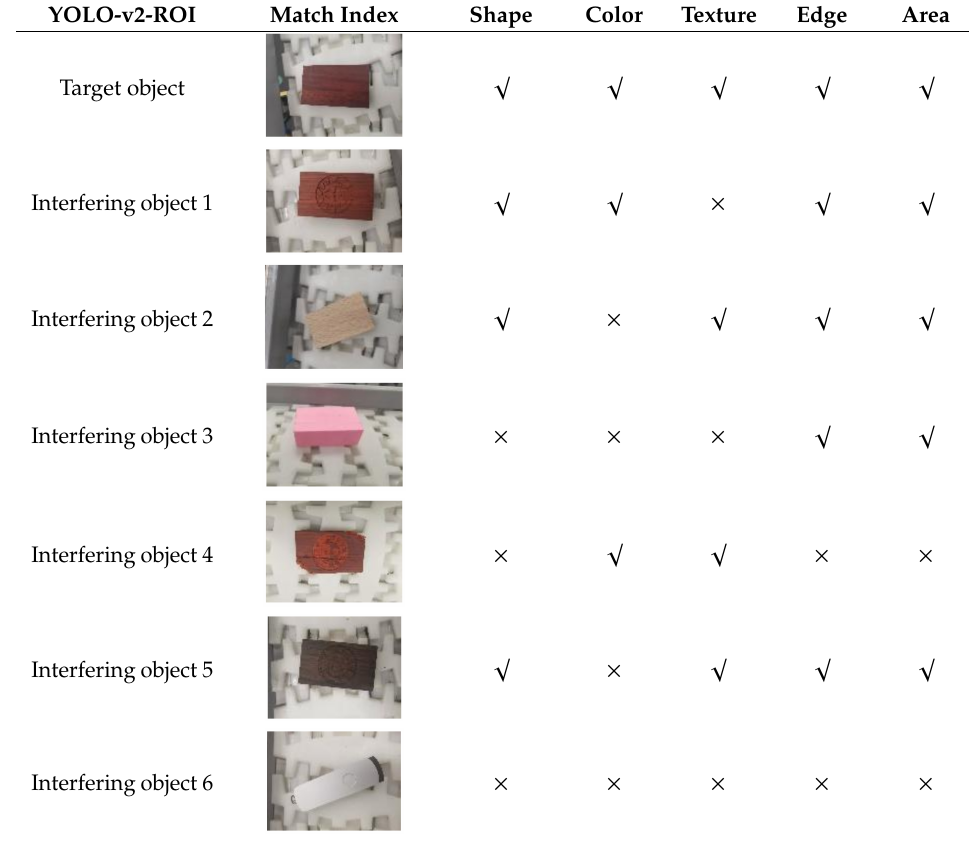
Table 1. Description of the properties of the targets and interfering objects. YOLO-v2-ROI: You Only Look Once Version 2 Region of